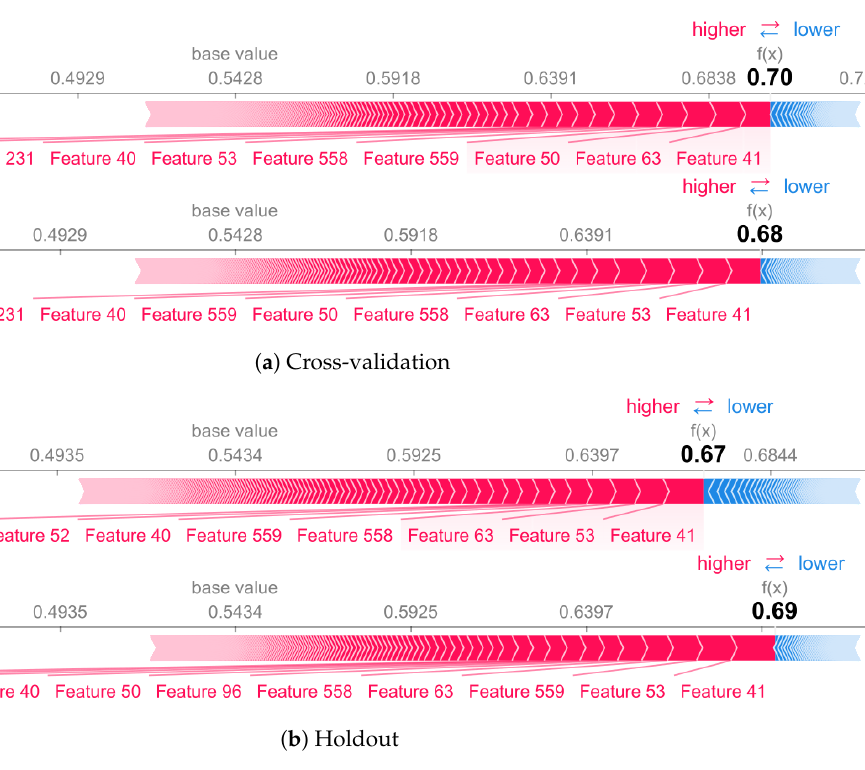
Figure 12. Sitting activity for cross-validation ( a ) and holdout ( b ) validation